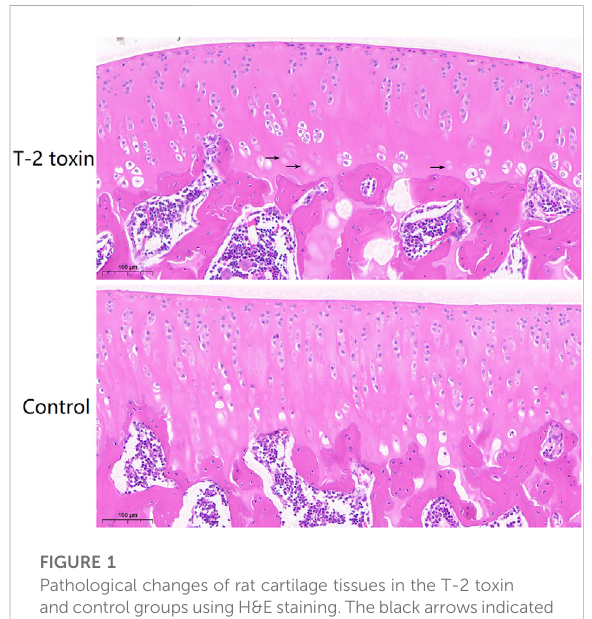
FIGURE 1 Pathological changes of rat cartilage tissues in the T-2 toxin and control groups using H&E staining. The black arrows indicated chondrocytes without the nucleus.